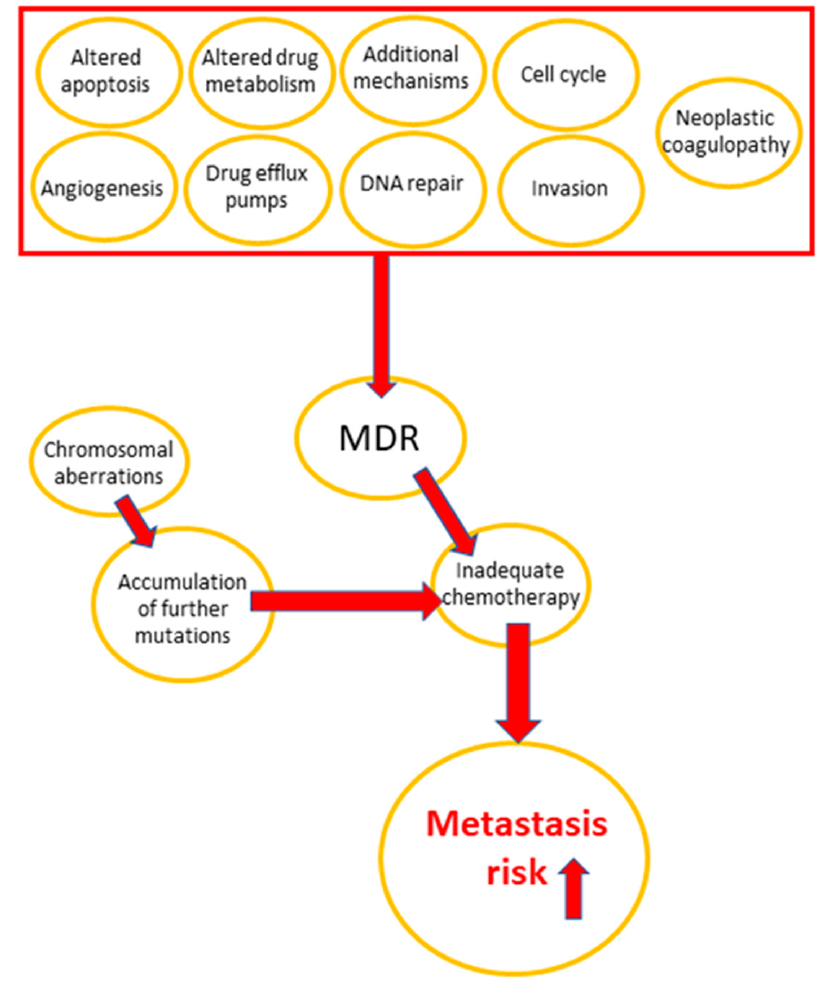
Figure 1. Effect of MDR-related mechanisms on cancer progression.